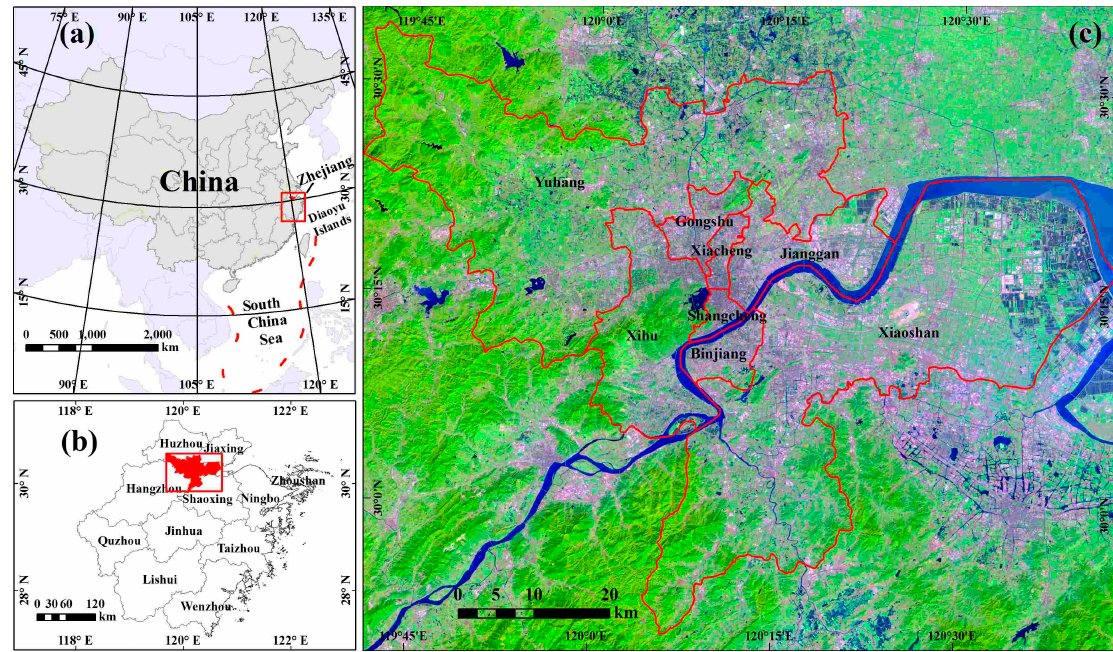
Figure 1. Location of the study area. ( a ) Location of Zhejiang province in China. ( b ) Location of Hangzhou Metropolitan Area (HMA) in Zhejiang province. ( c ) Overview of the HMA in a Landsat image taken in 2015 with a false colour composite.